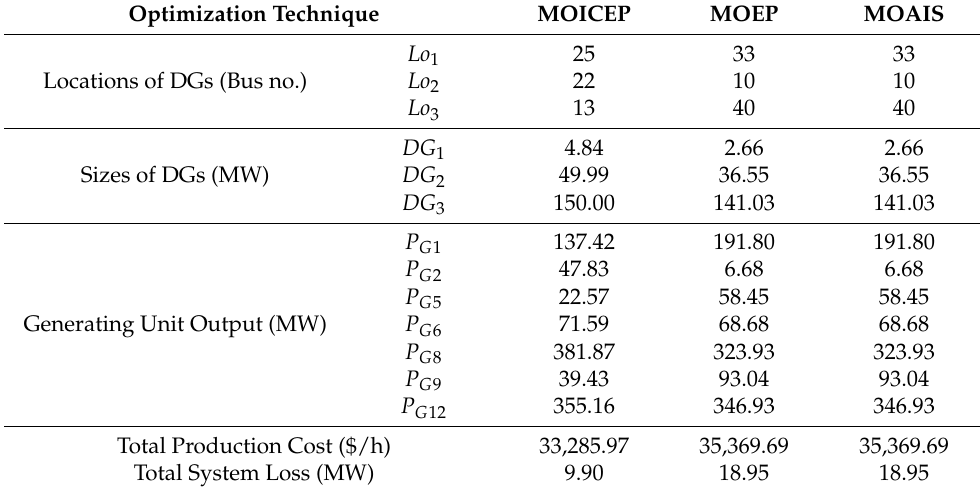
Table 3. Results of the integrated basic ED and DG installation of the IEEE 57-Bus RTS ( w 1 = 0.9 and w 2 =